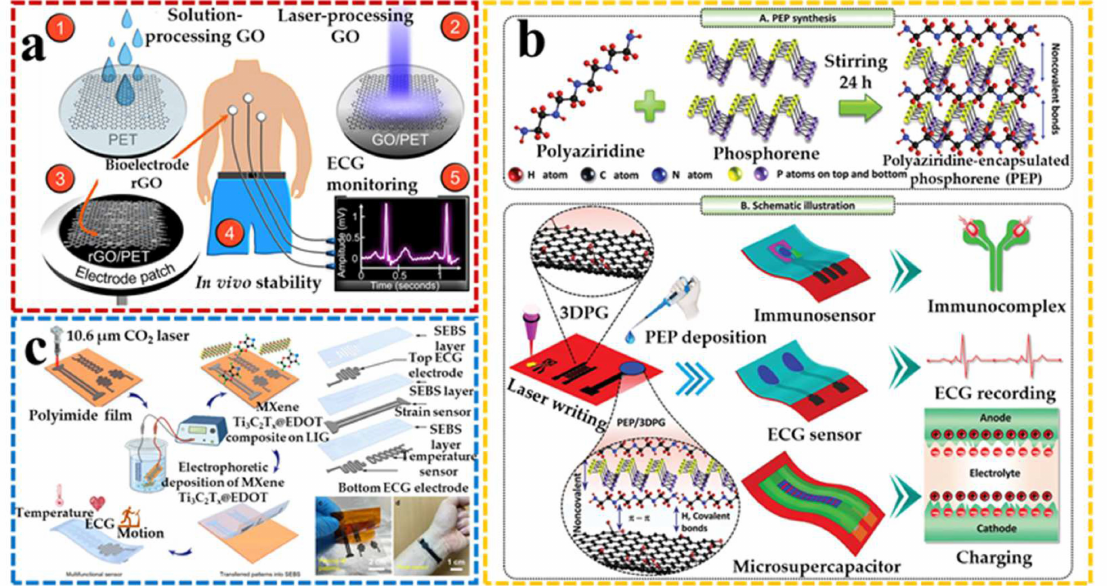
Figure 3. Laser-induced/scribed graphene ECG electrodes. ( a ) Schematic illustration of the prepara- tion process of the LIG ECG electrode. Reprinted with permission from Ref. [64]. Copyright 2020, Elsevier. ( b ) Preparation of the polyaziridine-encapsulated phosphorene composite ( above ) and the schematic diagram of the ECG electrode, immunosensor, etc. based on 3D porous LIG ( below ). Reprinted with permission from Ref. [65]. Copyright 2021, Wiley. ( c ) Schematics of the fabrication process and photos of the LIG–SEBS-based multifunctional sensors. Reprinted with permission from Ref. [67]. Copyright 2022, Springer